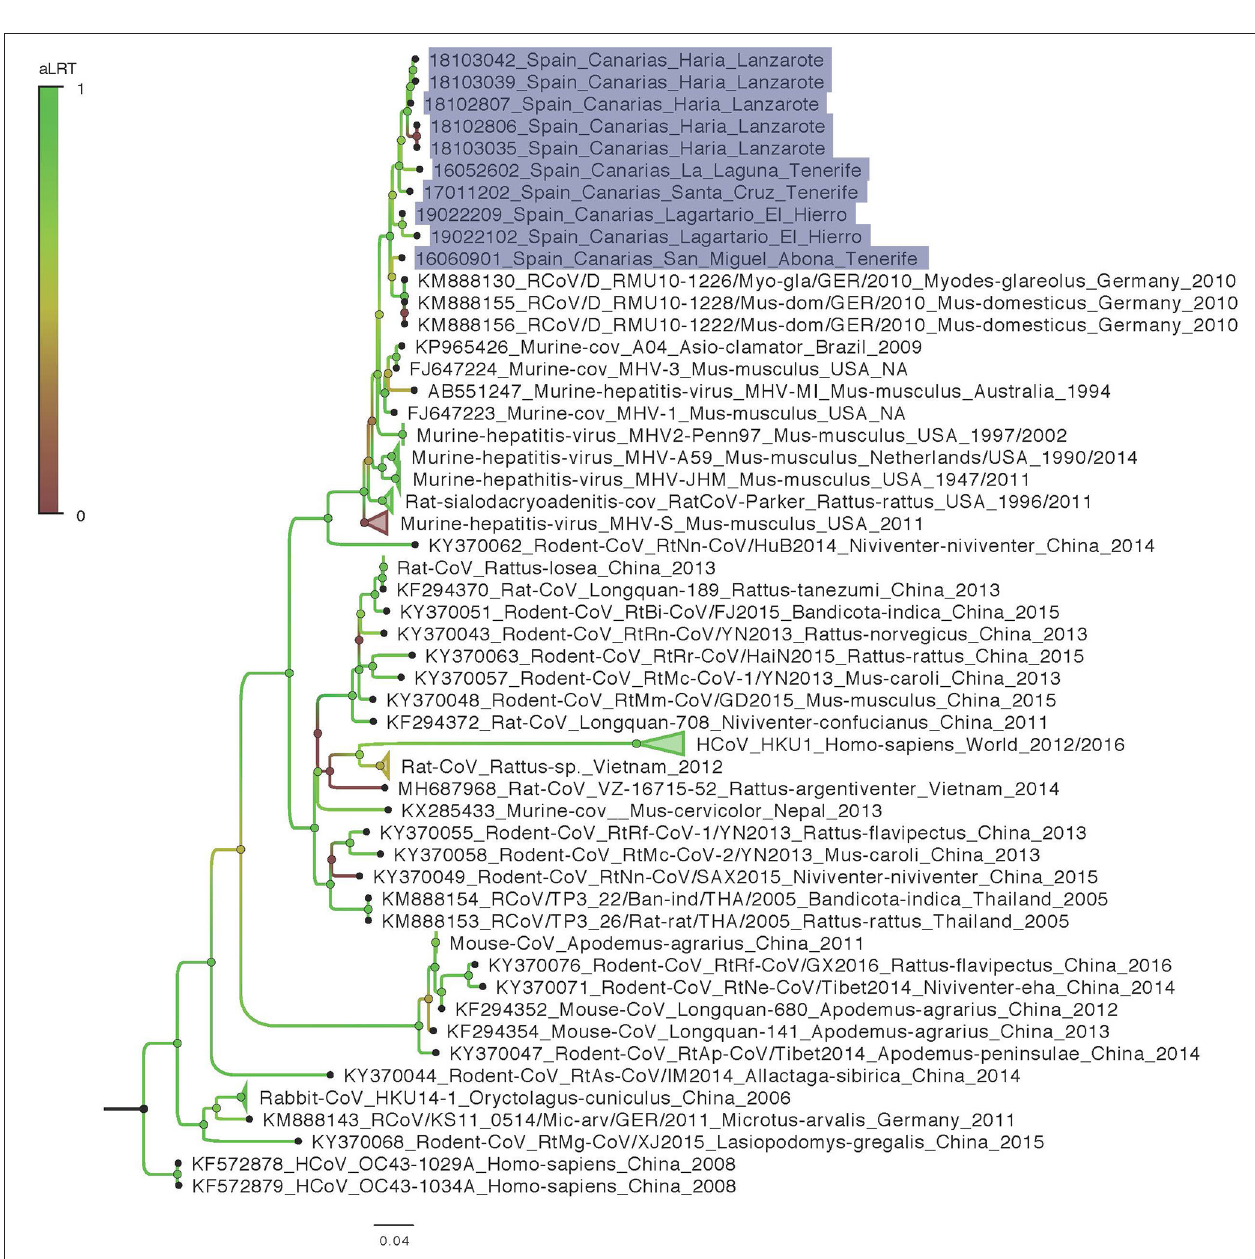
FIGURE 2 | Maximum likelihood phylogeny of genetic sequences detected in the study with sequences representing the world diversity of Coronavirinae Betacoronavirus Embecovirus. Samples from this work are highlighted in purple. Names are built as follows for the reference sequences: Accession number_denomination_strain_host genus-species_country_date and for samples from this work that all originate from Mus musculus species: Isolate code_Locality_Island (NA, not